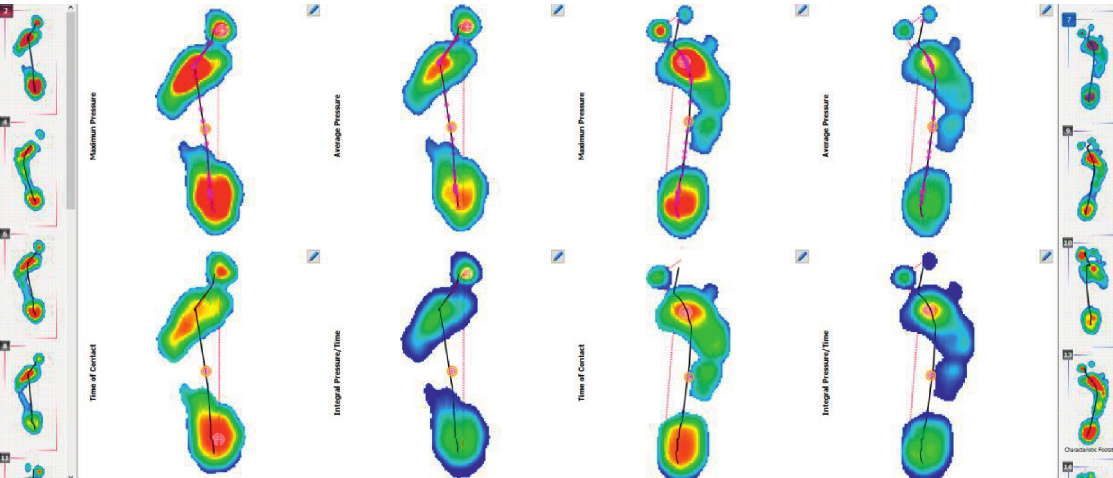
Figure 13: The assessment of the progression of the condition for patient no. 7: push off curve; the thin red line depicts overpronation propulsion of the left